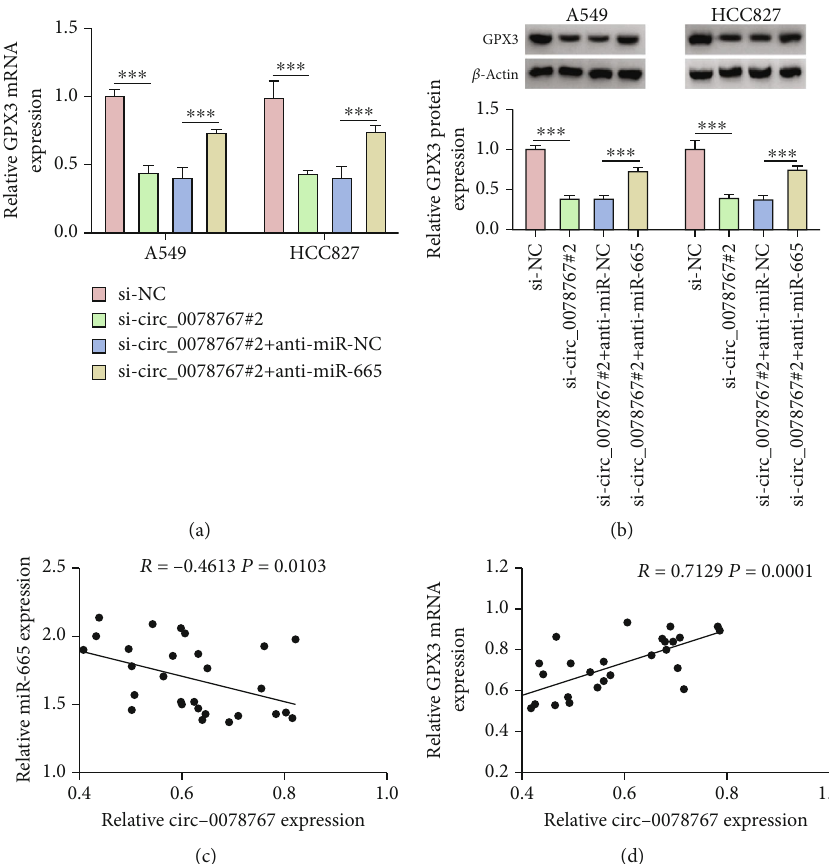
Figure 7: Circ_0078767 regulates the role of GPX3 via miR-665 in NSCLC. (a) The expression level of GPX3 was determined by qRT-PCR. (b) The protein level of GPX3 was determined by Western blot. (c, d) Pearson ’ s correlation analysis. ∗∗∗ P < 0 : 001